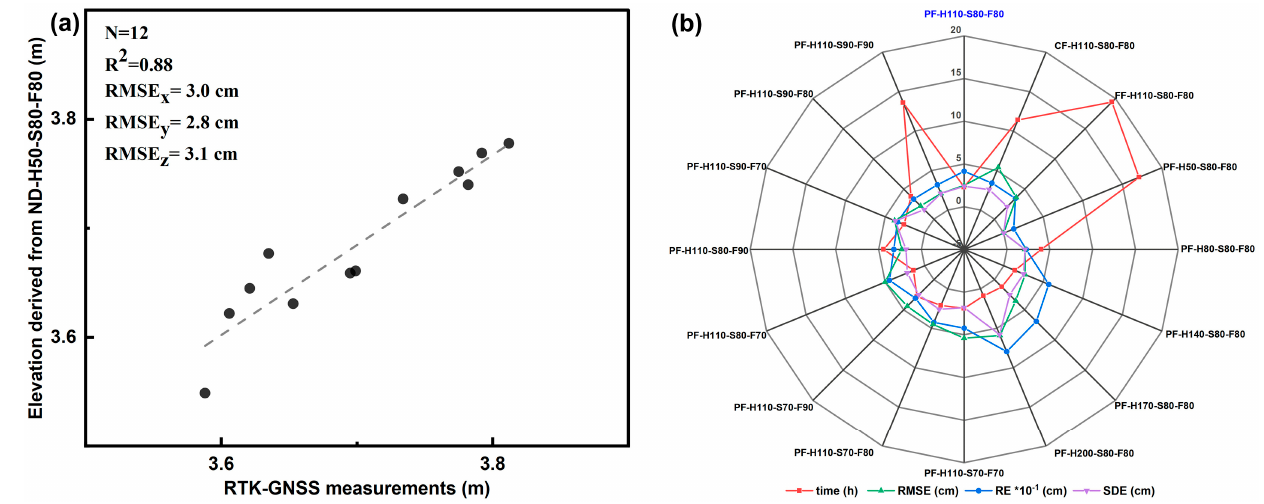
Figure 5. ( a ) Comparison between the elevations of checkpoints extracted from UAV-based photo- grammetric DEM acquired at 50 m altitude and RTK-GNSS measurements; and ( b ) UAV photo- grammetric accuracy and efficiency under different flights. Table 3. Reprojection error, the root-mean-square error, and the standard deviation of error for each of UAV flight experiments with different photogrammetric configurations.